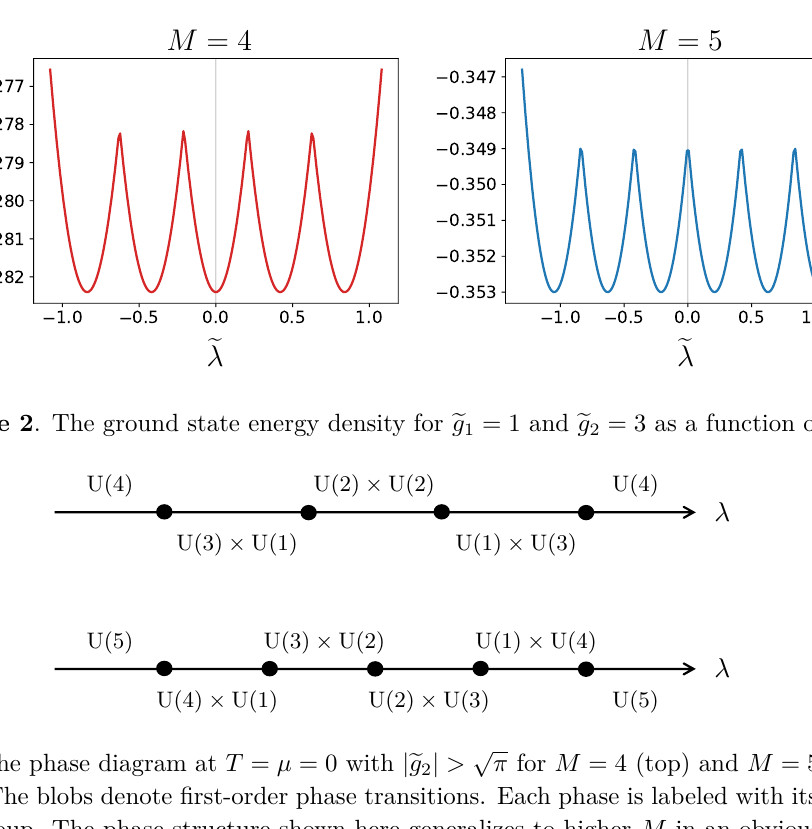
Figure 3 . The phase diagram at T = µ = 0 with | at large N . The blobs denote first-order phase transitions. Each phase is labeled with its unbroken symmetry group. The phase structure shown here generalizes to higher M in an obvious